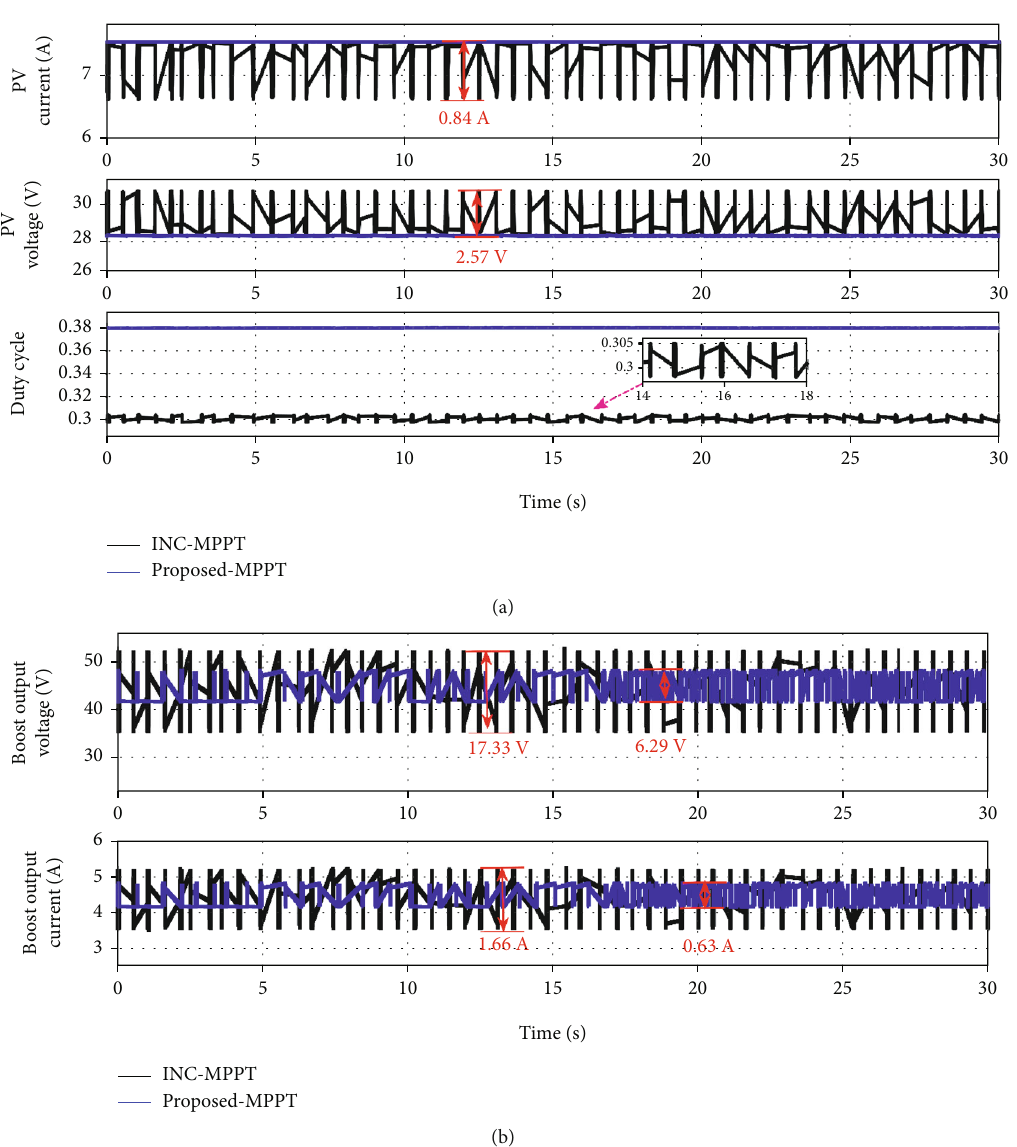
Figure 27: RT-LAB real-time results of the output current and voltage waveforms of both MPPT schemes under STC: (a) PV array and (b) TLBC.